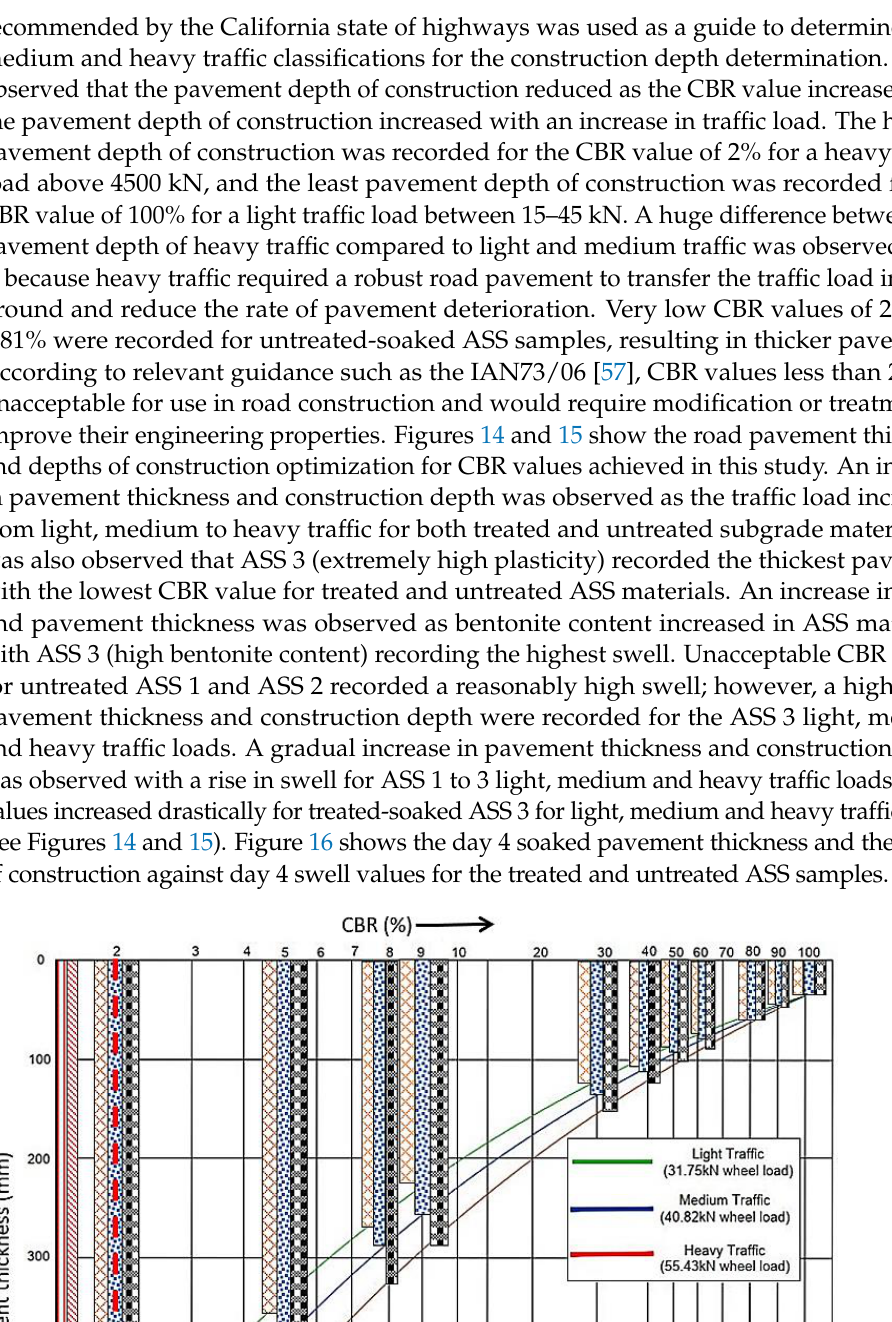
Figure 14. Road pavement thickness optimization using the chart for pavement thickness determi- nation.